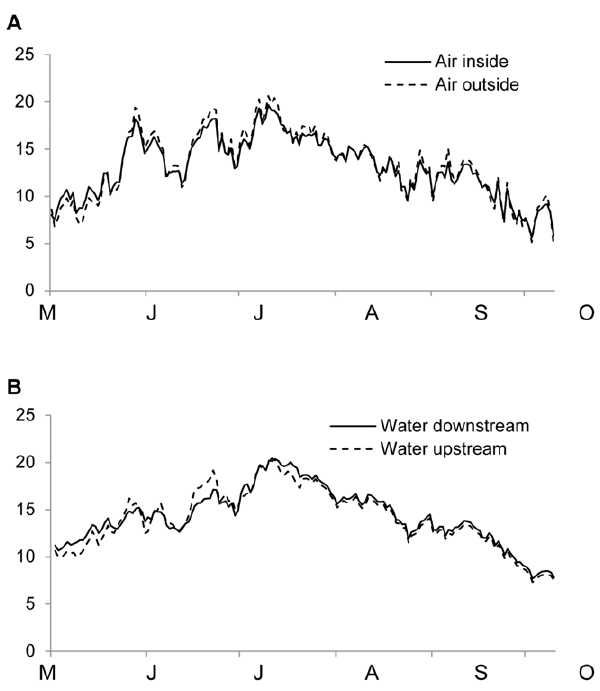
Figure 2. Air and water temperature. Downstream (continuous line) and upstream (dashed line) daily mean air (A) and water (B) temperature ( u C) in Sundtja¨rnsba¨cken Creek during the five month study. Error bars have been omitted for clarity.